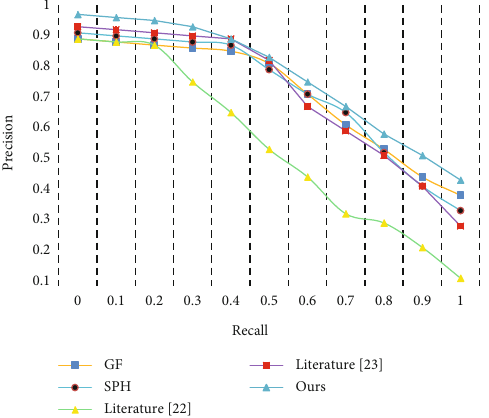
Figure 9: Precision and recall